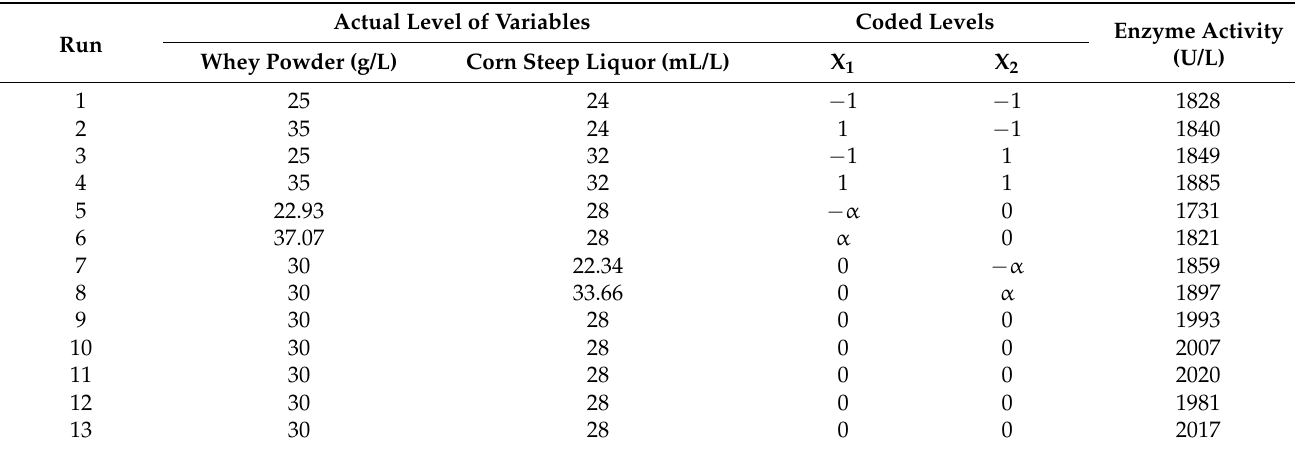
Table 3. Experimental design and results of central composite design.